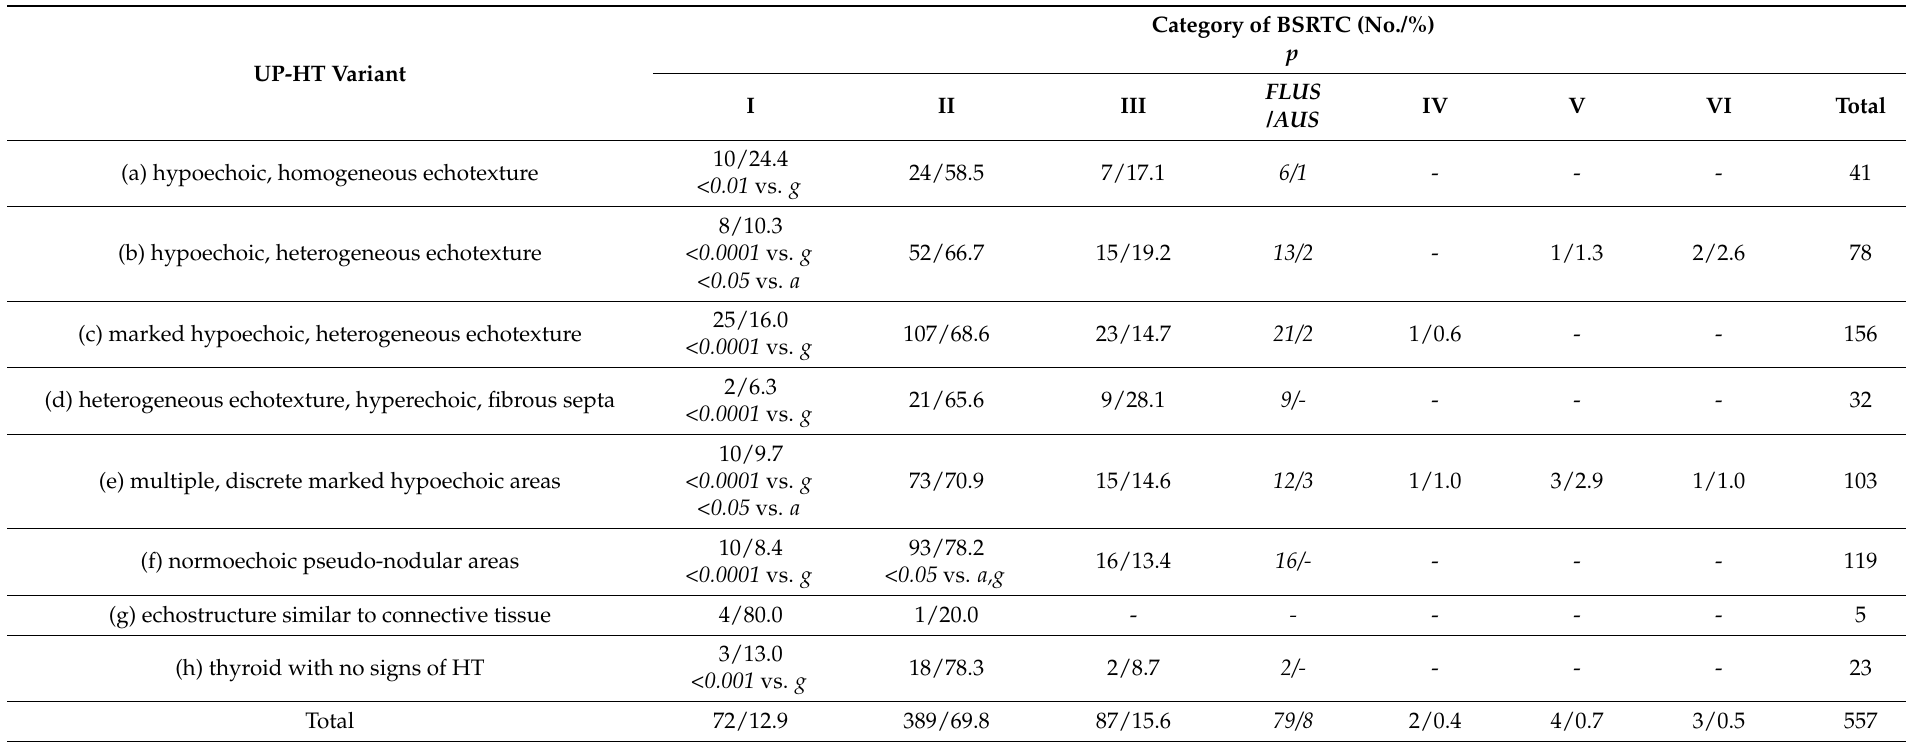
Table 3. Distribution of the categories of FNA outcomes of the thyroid nodules according to the Bethesda System for Reporting Thyroid Cytology (BSRTC) in 557 patients with Hashimoto (cid:48) s thyroiditis in relation to the ultrasound pattern of the thyroid parenchyma